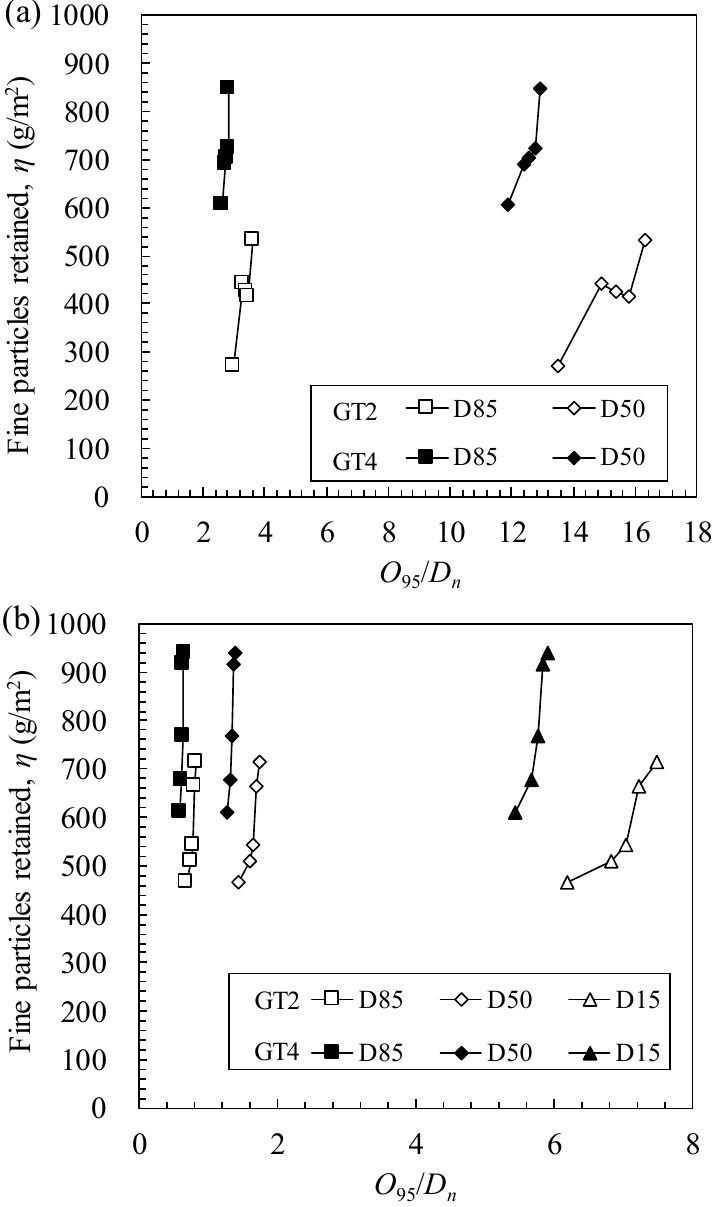
Figure 9. The amount of fine particles retained in the η and O 95 / D n ratios: ( a ) C-GT2/GT4 combina- tions; ( b ) M-GT2/GT4 combinations.